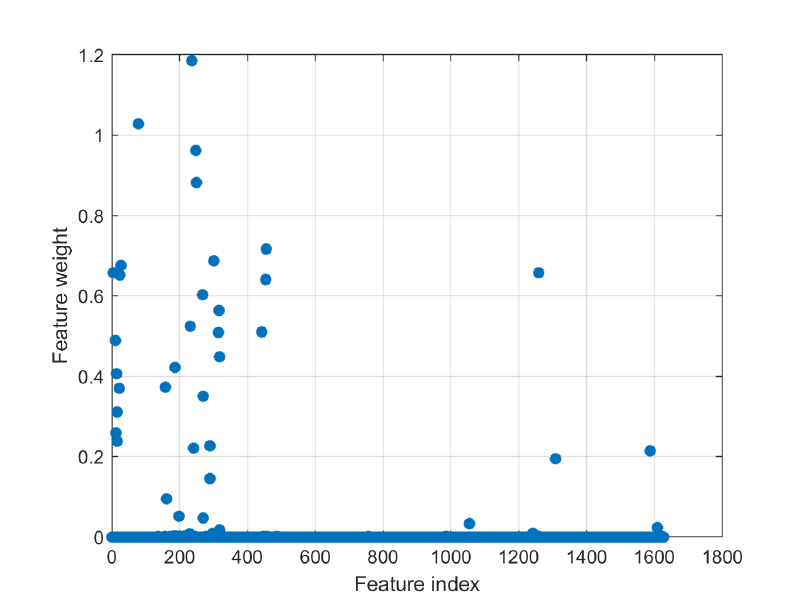
Figure 4. The average loss values versus lambda ( λ ) values.